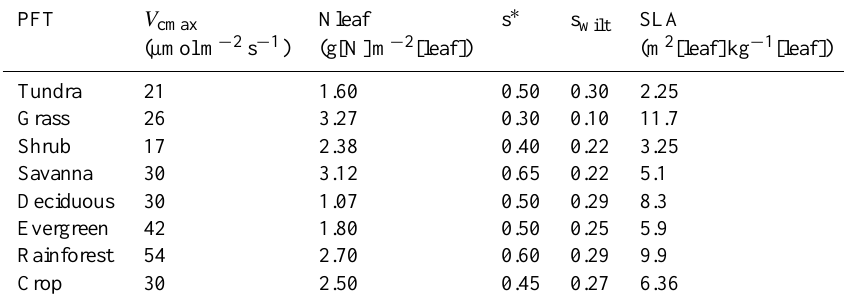
Table A1. PFT-specific photosynthesis parameters used in Yale-E2 global carbon-chemistry-climate model. PFT V cmax Nleaf s ∗ s wilt SLA (µmolm − 2 s − 1 ) (g[N]m − 2 [leaf]) (m 2 [leaf]kg − 1